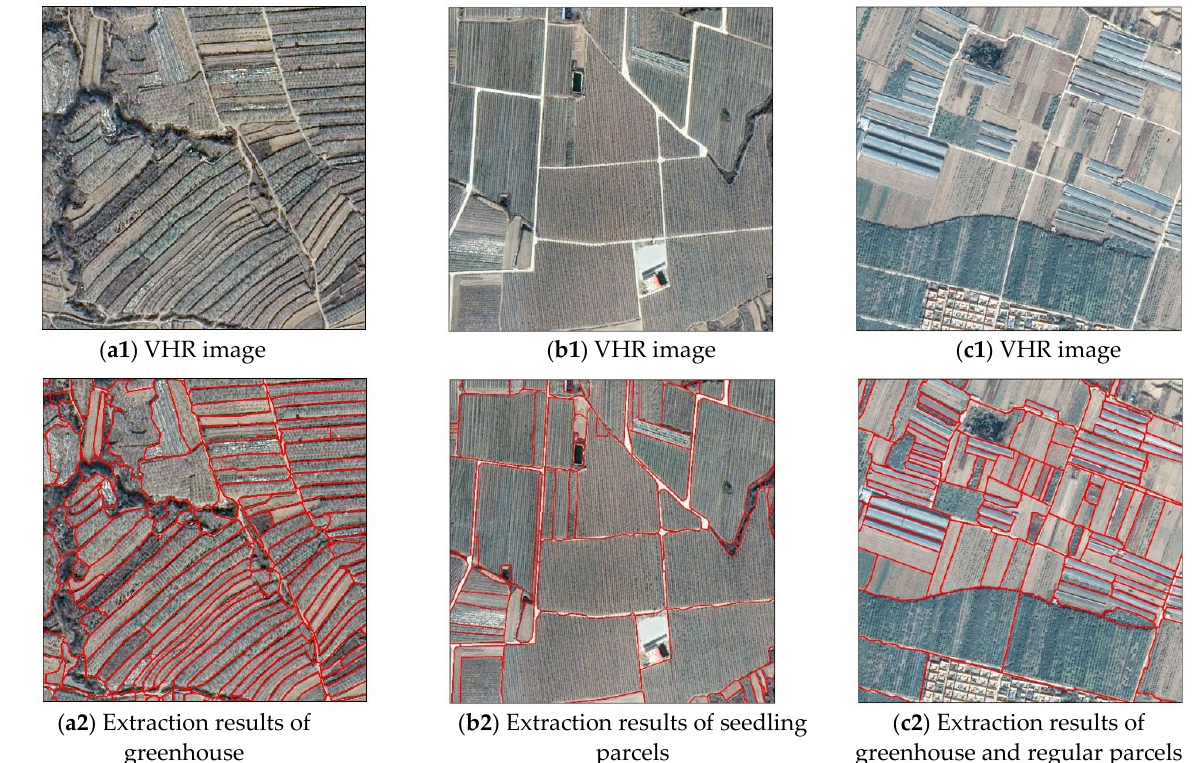
Figure 11. Parcel extraction results: ( a )–( c ) are the sub ‐ regions of the study area; the geographical location in this study is shown in (P1, P2, P3) in Figure 9; ( a2 ) shows the extraction effect of terraced parcels; ( b2 ) shows the extraction effect of seedling parcels; and ( c2 ) shows the extraction effect of regular parcels and greenhouses. Table 4. Evaluation of parcel extraction